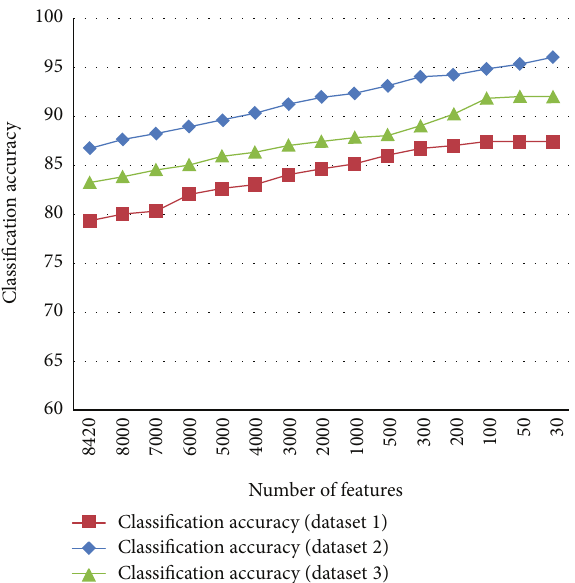
Figure 10: Number of features versus classification accuracy on three